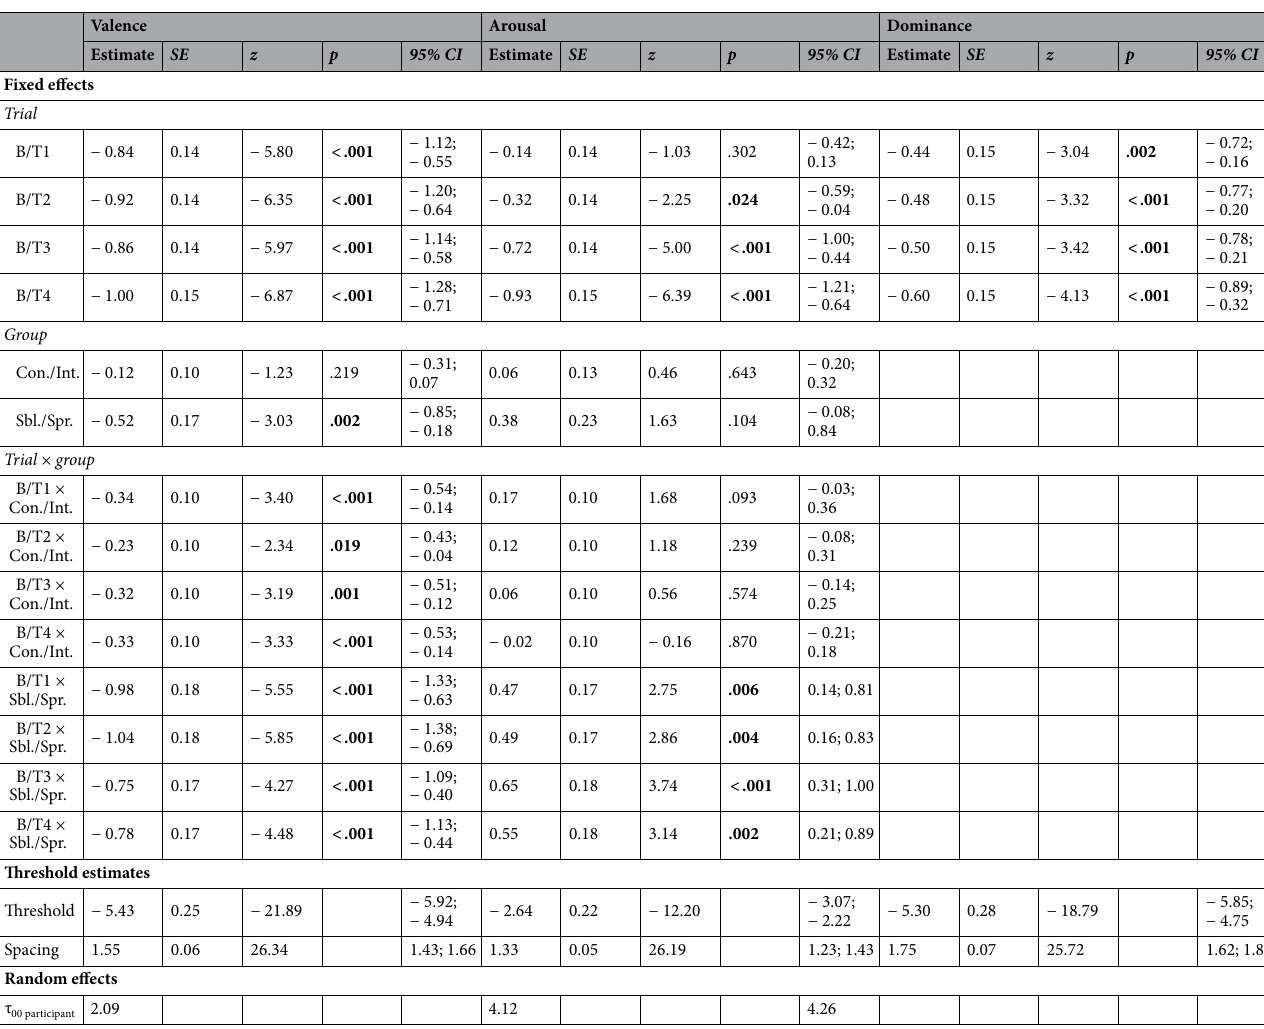
Table 1. Final cumulative link mixed models for the dependent variables valence, arousal and dominance. B Baseline, T1 Trial 1, T2 Trial 2, T3 Trial 3, T4 Trial 4, Con. Control group, Int. Intervention, Sbl . Subliminal group, Spr. Supraliminal